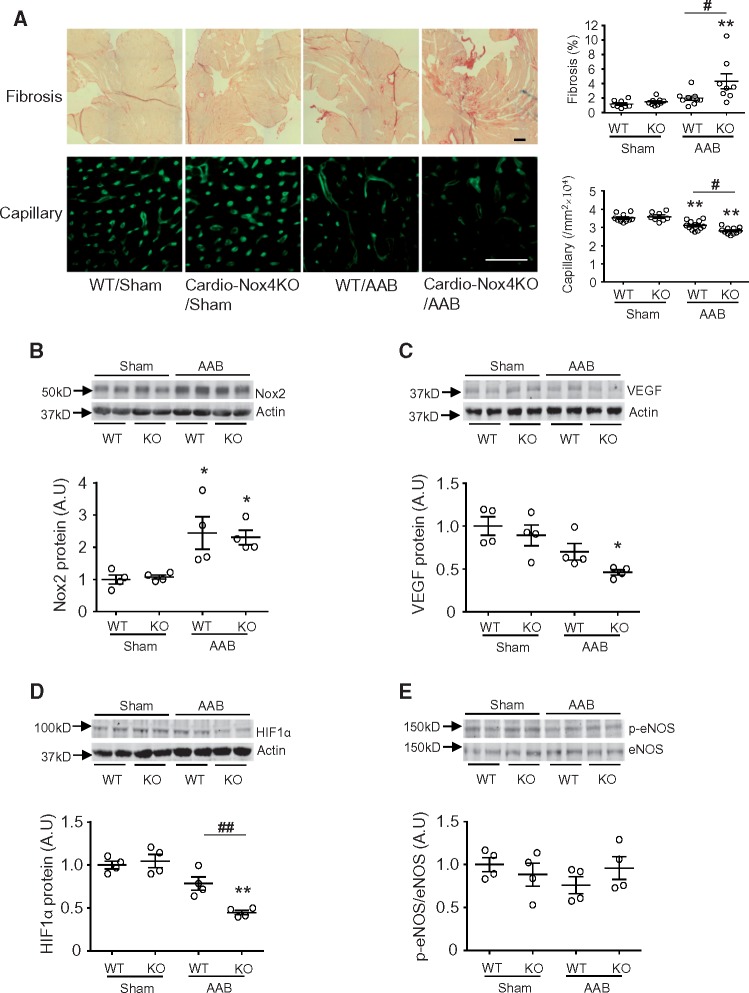
Cardio-Nox4KO mice display higher interstitial fibrosis and lower capillary density after 6 weeks abdominal aortic banding (AAB). (A) Representative LV sections from Cardio-Nox4KO mice and WT littermates stained for myocardial fibrosis and capillaries; scale bars 50 μm. Mean data are shown on the right (n = 8–12/group). (B) Nox2 protein levels in Cardio-Nox4KO and WT mice (n = 4/group). (C–E) Protein levels of VEGF-A, HIF1α, p-eNOS, and total eNOS in LV of Cardio-Nox4KO mice compared to respective WT. Representative immunoblots are shown at the top and mean data below (n = 4/group). *P < 0.05, **P < 0.01 vs. respective sham controls. #P < 0.05, ##P < 0.01 vs. WT/AAB, two-way ANOVA with Tukey’s Multiple Comparison Test. All data are presented as mean ± SEM.